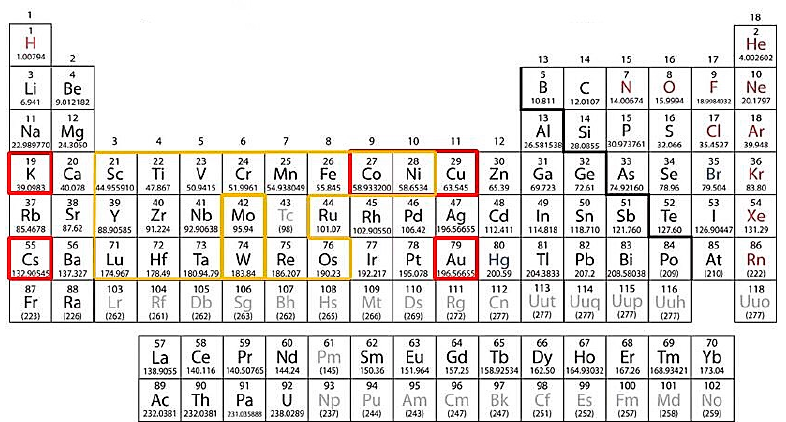
Figure 9. The distribution of elements in periodic table for the catalysts used in CO 2 utilization process. Red: active components; Yellow: supports.